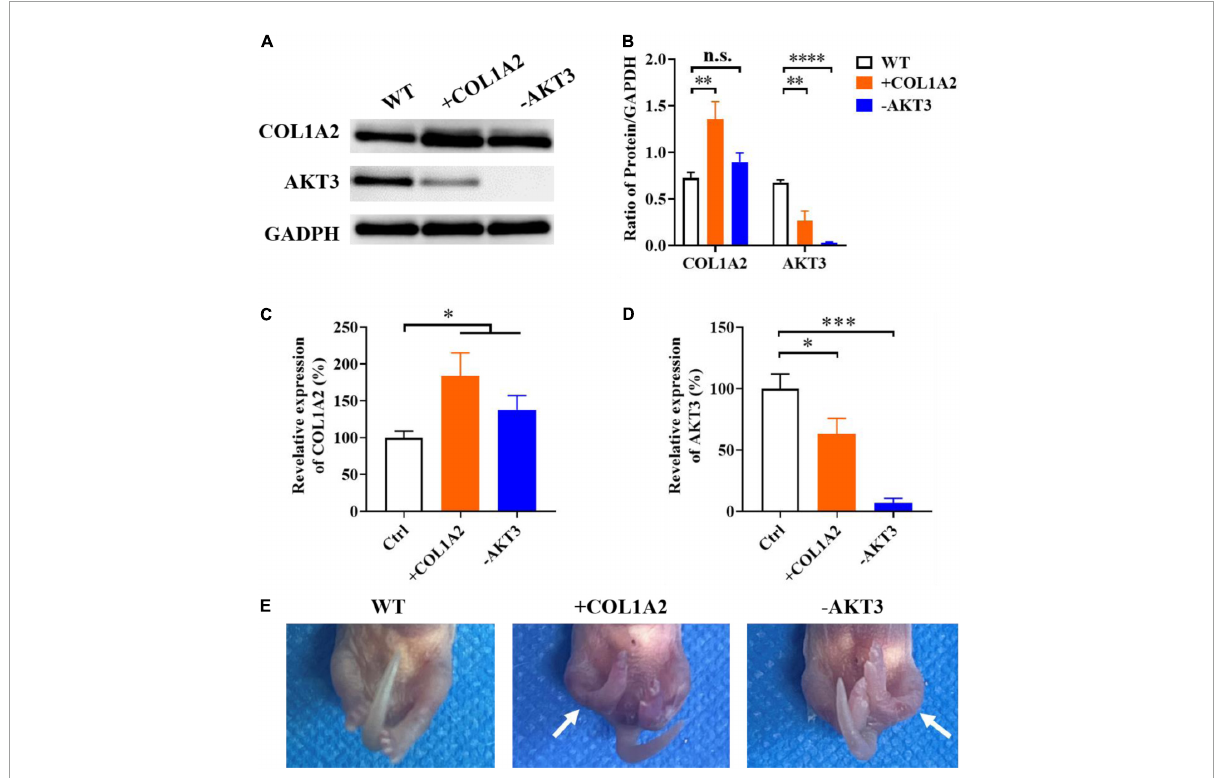
FIGURE3 Functional identification of the target genes using COL1A2 Knock-In (+ COL1A2 ) and AKT3 Knock-Out (- AKT3 ) transgenic mice. (A) Western blot of plasma COL1A2 and AKT3 proteins. (B) Quantification of protein in panel (A) . qRT-PCR analyzation of plasma COL1A2 (C) and AKT3 (D) expression at the transcriptional level. (E) Morphological observation of the mice pups. Data are means ± SD ( n = 3). Statistical significance was determined using one-way ANOVA followed by Tukey’s test; n.s., no significance; ∗ p < 0.05; ∗∗ p < 0.01; ∗∗∗ p < 0.001; ∗∗∗∗ p <